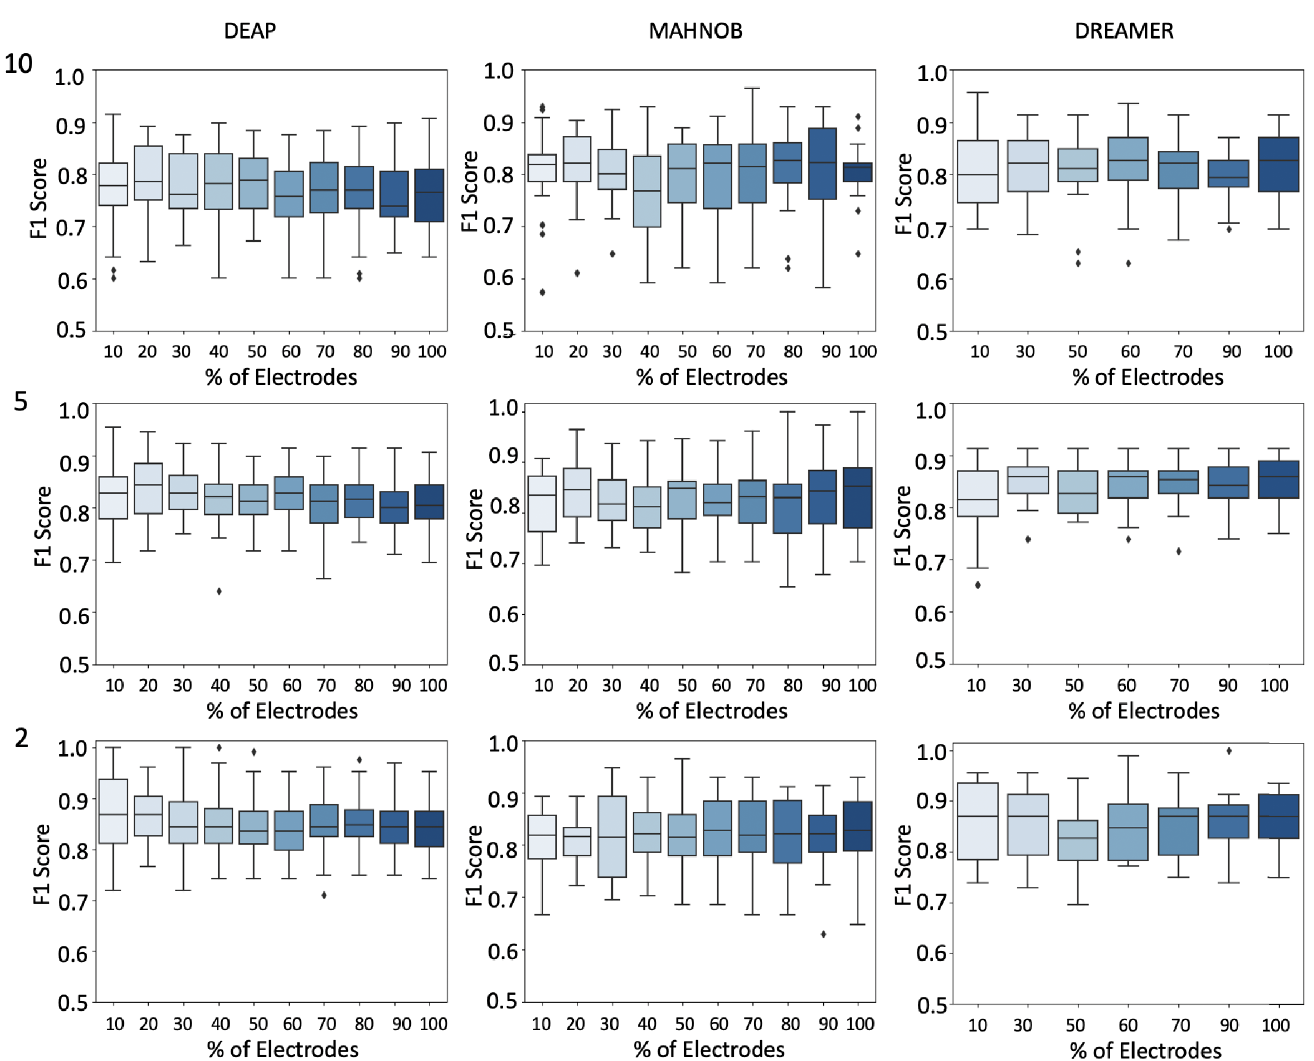
Fig 6. Arousal: F1 scores for various ranked electrode channels selections (10%,20%, ... ,100%) on the x-axis, and F1 score on the y-axis. We show datasets vertically, and epoch sizes (10s, 5s, and 2s) horizontally. Each box plot depicts f1 scores across trials.